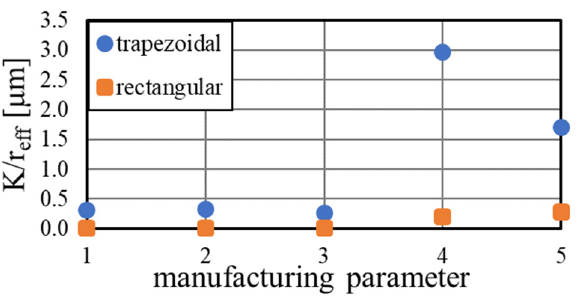
Figure 13. Performance of the trapezoidal and rectangular grooved wick dependent on the manu- facturing parameter, calculated by rate-of-rise experiments.